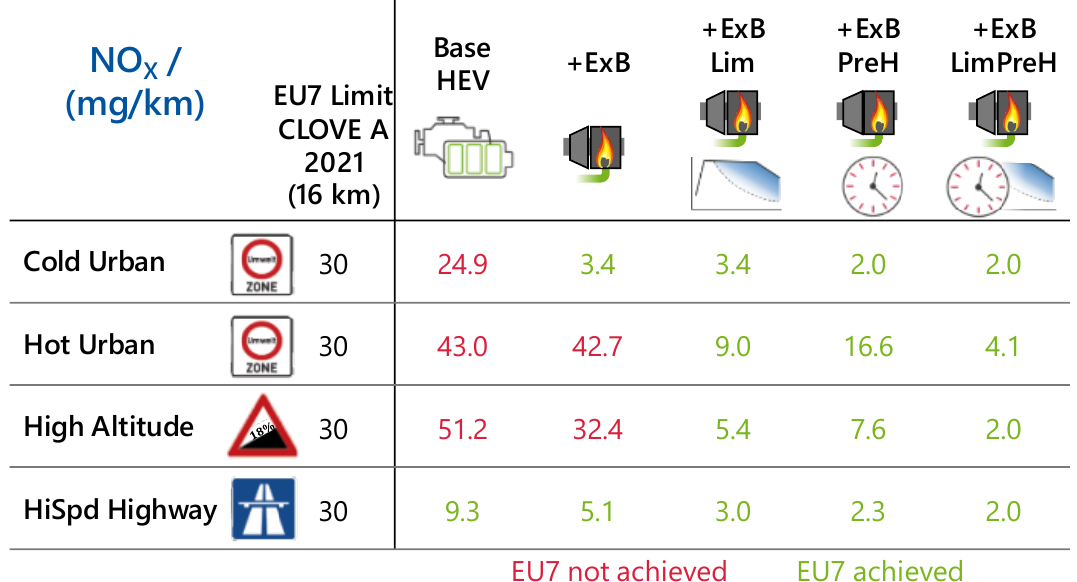
Figure 13. Exhaust burner results for Euro 7 scenarios.